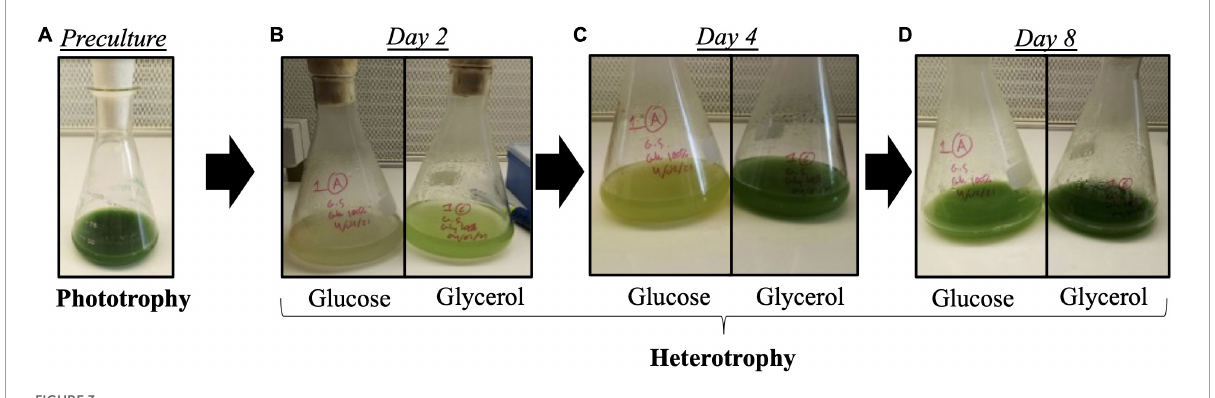
FIGURE3 Images of Galdieria sulphuraria cultures. Cultures in phototrophy as a preculture (A) , or in heterotrophy after 2 days (B) , 4 days (C) , and 8 days (D) in the presence of 25 mM of glucose or 50 mM of glycerol as carbon source. Yellow color of the culture mediated by the pigment loss can clearly be observed during exponential phase (B) only when glucose is present. After glucose depletion at stationary phase (D) , a return of the green color is observed.